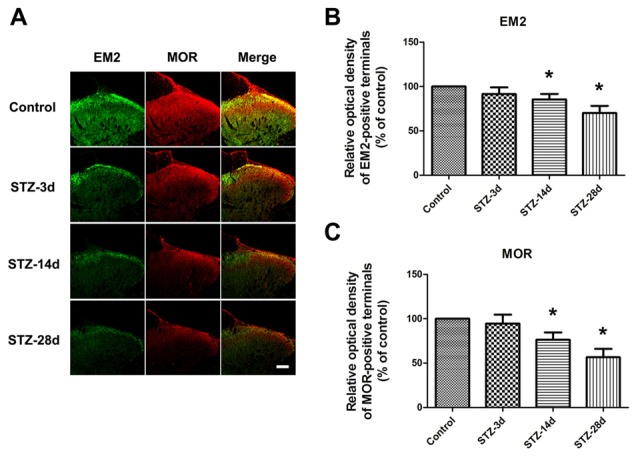
Photomicrographs indicate the localization of endomorphin-2 (EM2) and μ-opioid receptor (MOR) in the spinal cord. Fluorescent photographs show how EM2-immunopositive (IP) and MOR-IP terminals are distributed in the spinal dorsal horn (A). Scale bar: 100 μm in (A). Statistical analysis of the relative optical density (ROD) of EM2-IP terminals (B) and MOR-IP terminals (C) in different groups. The sample of the control group was set at 100%. Mean ± SD, n = 6 per group, *p < 0.05 vs. non-diabetic control rats.